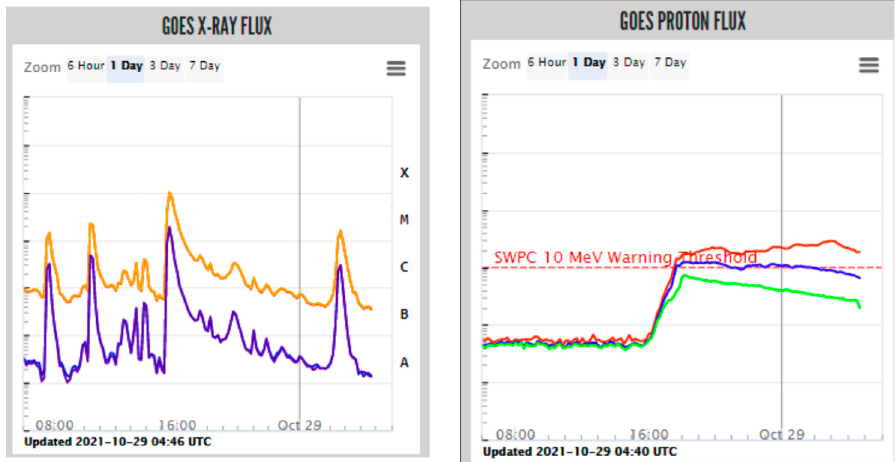
Figure 1. The X1.0 solar flare ( left ) and the proton flux as detected by the GOES satellites ( right ) during the GLE.